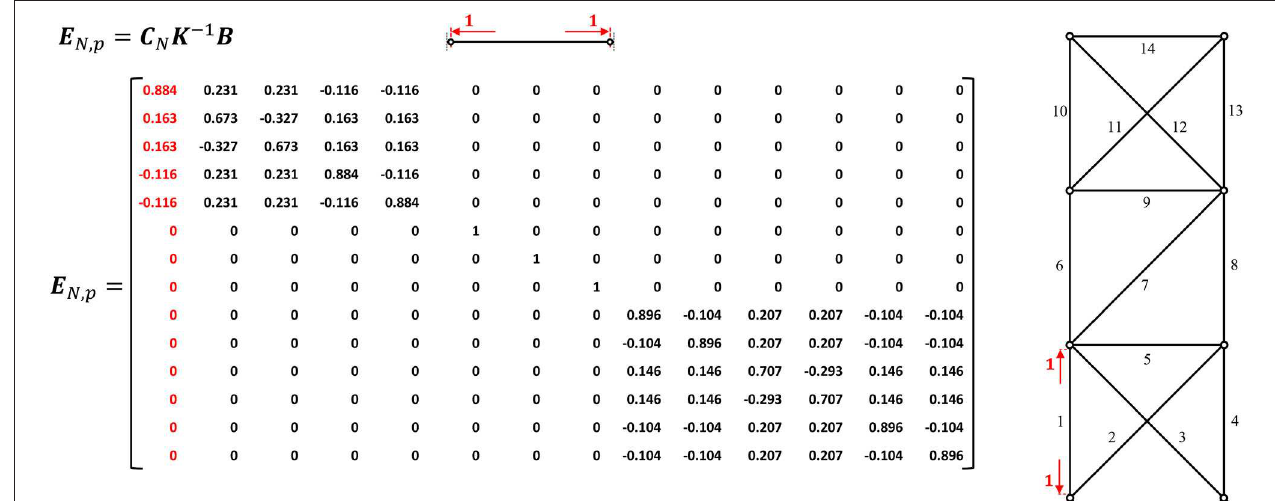
FIGURE 3 | Influence matrix of axial forces due to parallel linear actuation E N , p of an exemplary truss.